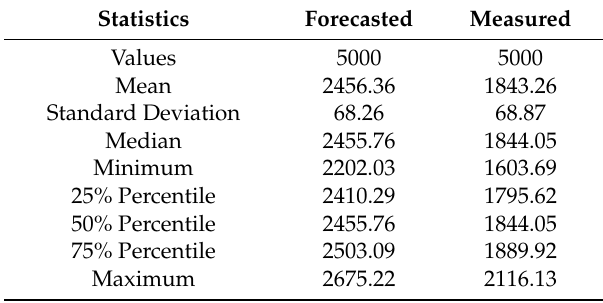
Figure 9. Calculation of the unit cost of energy production based on the forecasted energy values.